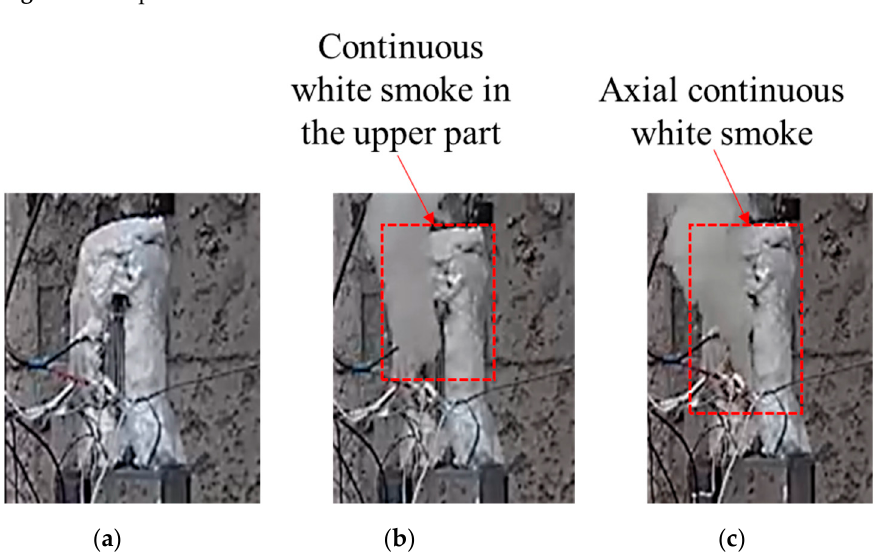
Figure 9. Response of cook-off bomb of shot 2. ( a ) Initial ignition. ( b ) Secondary jump. ( c ) Third jump. The temperature changes at various locations in shot 3 after ignition are shown in Figure 10. The initial ignition position appeared at the center and upper part at the same time. After 6.2 s, further temperature jumps occurred at both locations with temperature rises of 234.4 and 277.8 °C, respectively. A temperature rise of 294.4 °C appeared in the lower part after 4.6 s. Combined with the camera image (see Figure 11), first, a small amount of intermittent white smoke was sprayed from the upper part of the slit. Then, a large amount of continuous white smoke was obviously sprayed from top to bottom, and the outer flame of the lower part lagged behind the upper middle part. Finally, the spray- ing was completed. Through shots 2 and 3, it can be seen that, compared to rapid heating, under the condition of slow heating, after the initial ignition point appears, it will directly grow into a violent combustion stage. There is no slow combustion stage, the growth is faster, and the temperature rise rate is higher. Analysis shows that when the heating rate is low, the temperature of JEOL explosive is relatively uniform and the internal energy is high. After the ignition of the explosive enters the first exothermic stage, the superposition of the released heat and the internal energy of the explosive makes the explosive quickly enter the second exothermic stage, and the explosive quickly releases a large amount of heat and enters the stage of intense combustion.